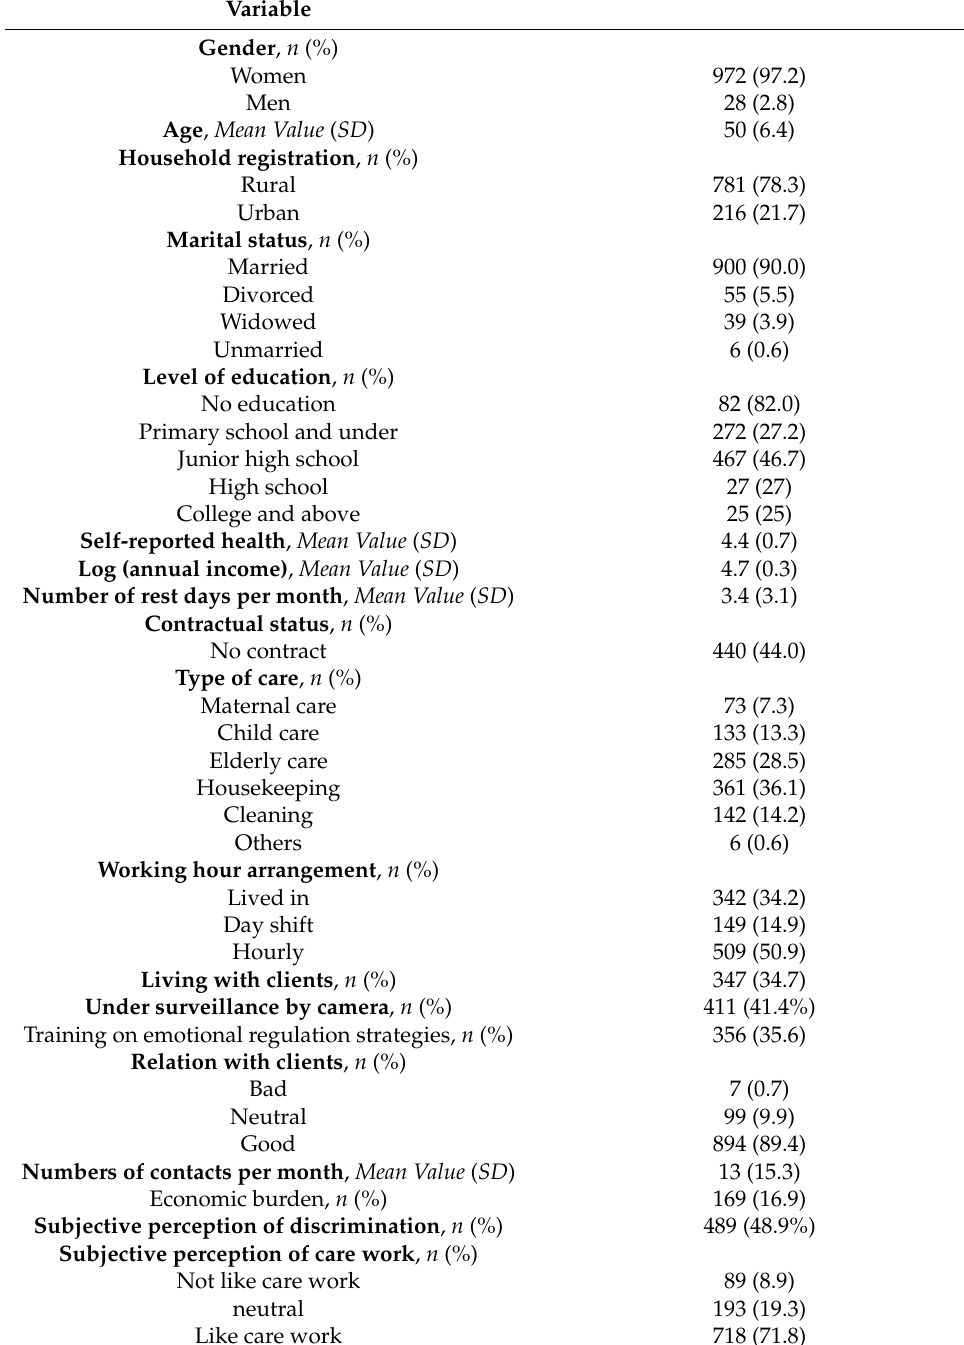
Table 1. Socio-demographic characteristics, work environment, social relations, economic burden, subjective perception of discrimination, and